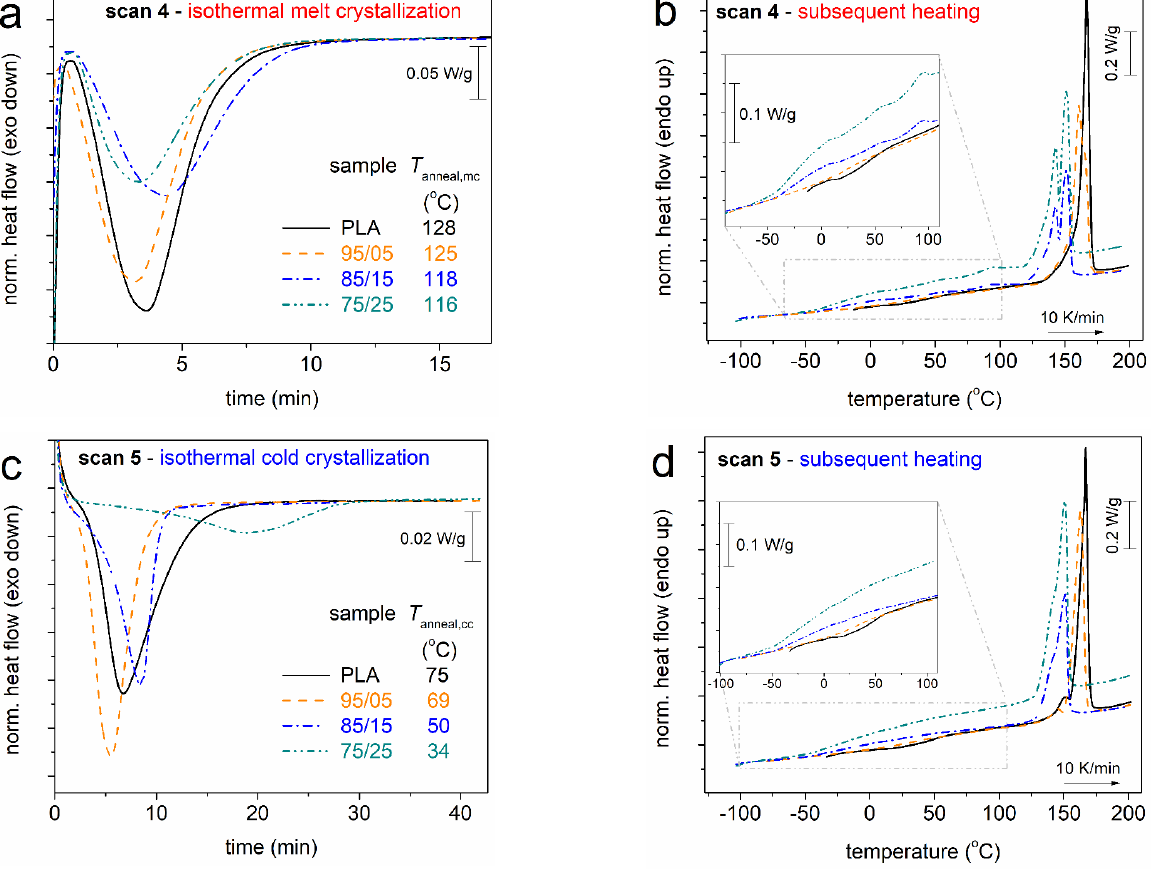
Figure 4. Comparative DSC traces of ( a , b ) Scan 4 and ( c , d ) Scan 5, for PLA and PLA/PPAd copoly- mers in terms of ( a , c ) isothermal crystallization and ( b , d ) the subsequent heating. The heat flow curves have been normalized to each sample mass. The insets to ( b ) and ( d ) show details in the temperature range of glass transition.